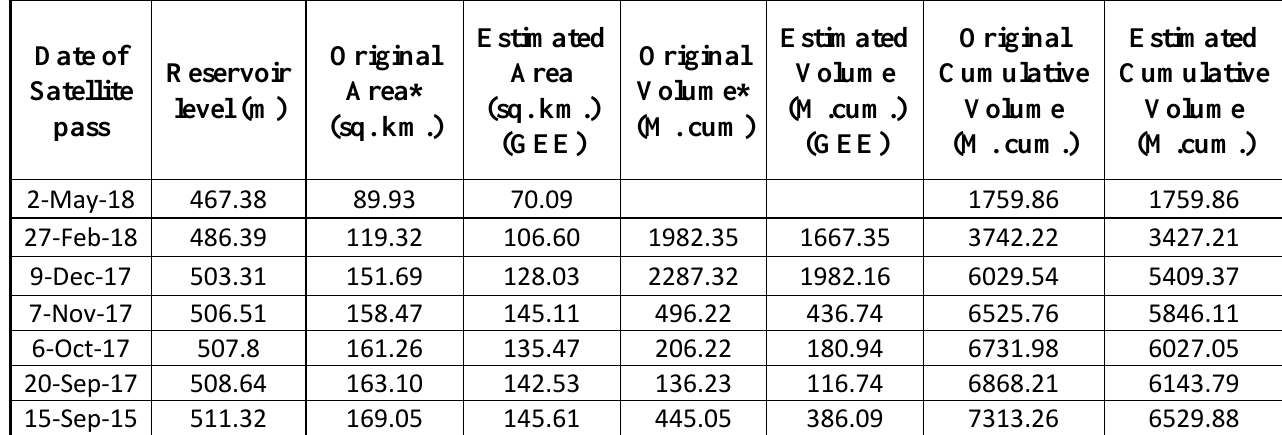
Fig 7 Elevation-Area-Capacity curves for Gobind Sagar Reservoir, India (2017-2018) Table 3. Assessment of sediments deposition of Gobind Sagar reservoir using remote sensing (GEE) for the year